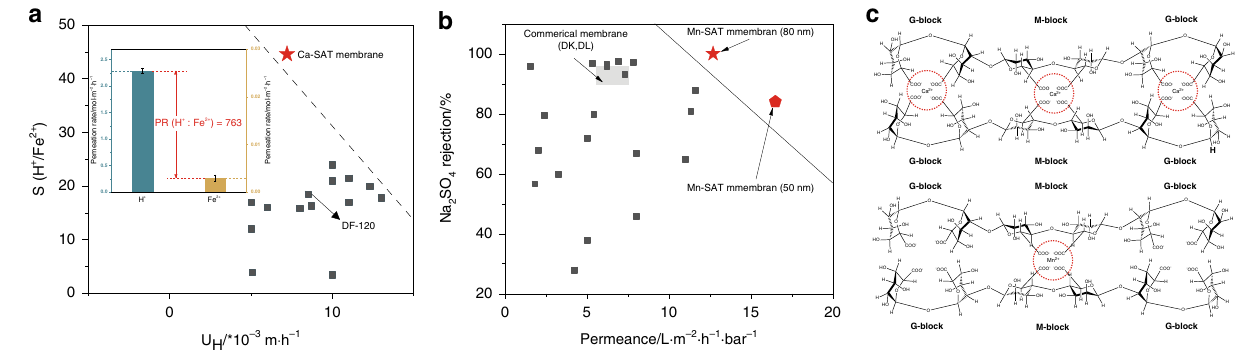
Fig. 5 Ion-sieving performance comparison and SA cross-linking mechanism. a Comparison of the separation performance of the Ca-SAT membrane and previously reported ion-exchange membranes, as well as the commercial DF-120 membrane. For detailed experimental conditions, see Supplementary Table 2. b Comparison of the separation performance of the Mn-SAT membrane and previously reported nano fi ltration membranes, as well as the commercial DK and DL membranes. For detailed experimental conditions, see Supplementary Table 3. c Schematic diagram of sodium alginate cross-linked with Ca 2 + and Mn 2 + . The error bars represent the standard deviations of three